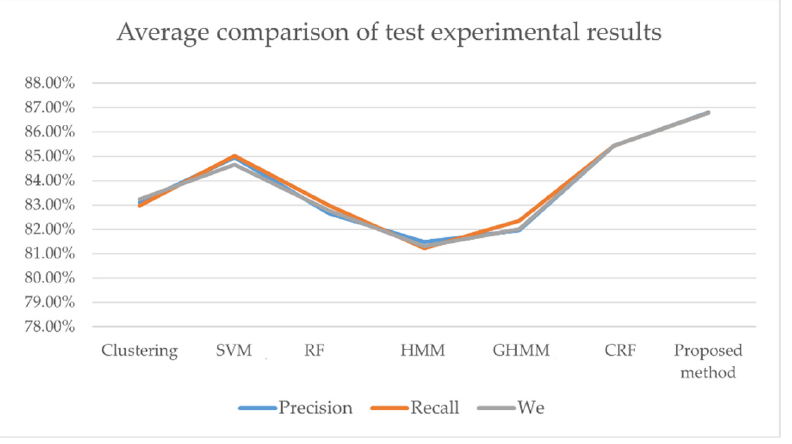
Figure 15. Average comparison of test experimental results (Clustering [10], SVM [11], RF [12], HMM [14], GHMM [13], CRF [16]).